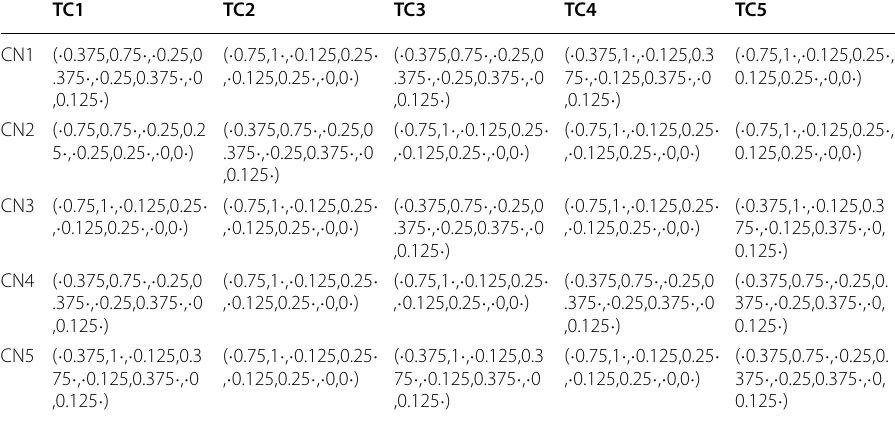
Table 26 Normalized values for the phase 1 of QFD